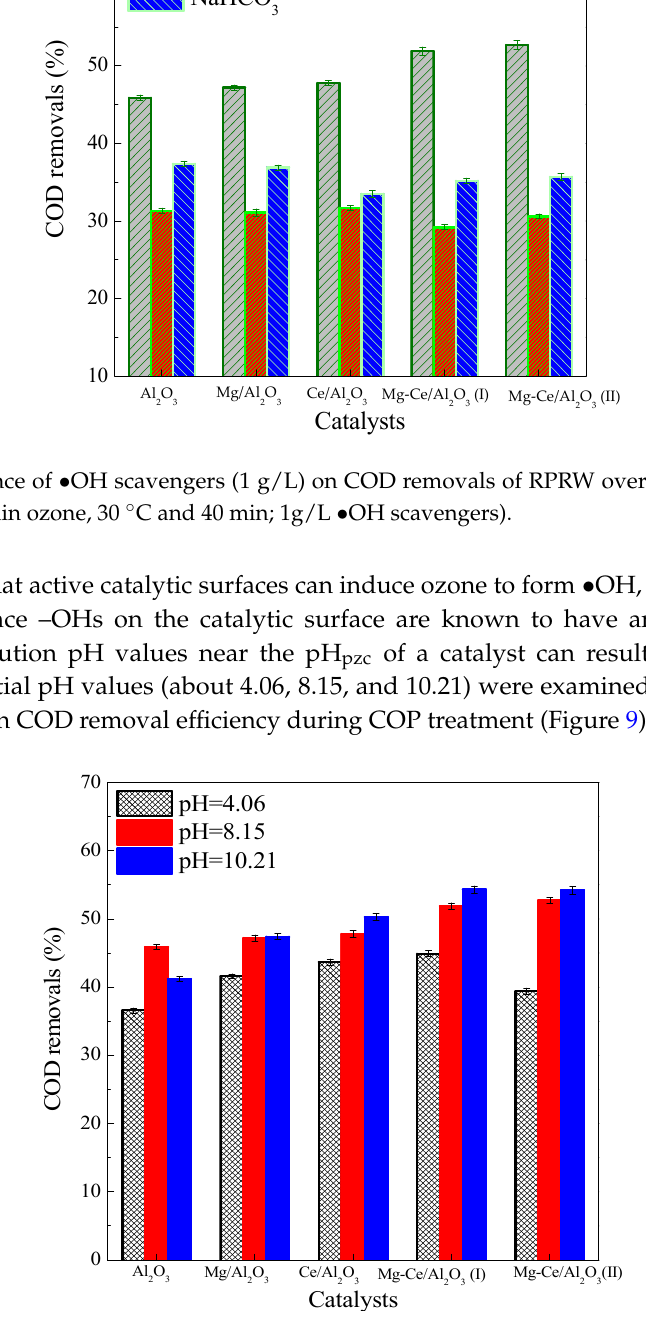
Figure 9. Influence of initial pH values on COD removals of RPRW over COPs (note: 0.5 g catalyst, 5 mg/min ozone, 30 °C and 40 min).